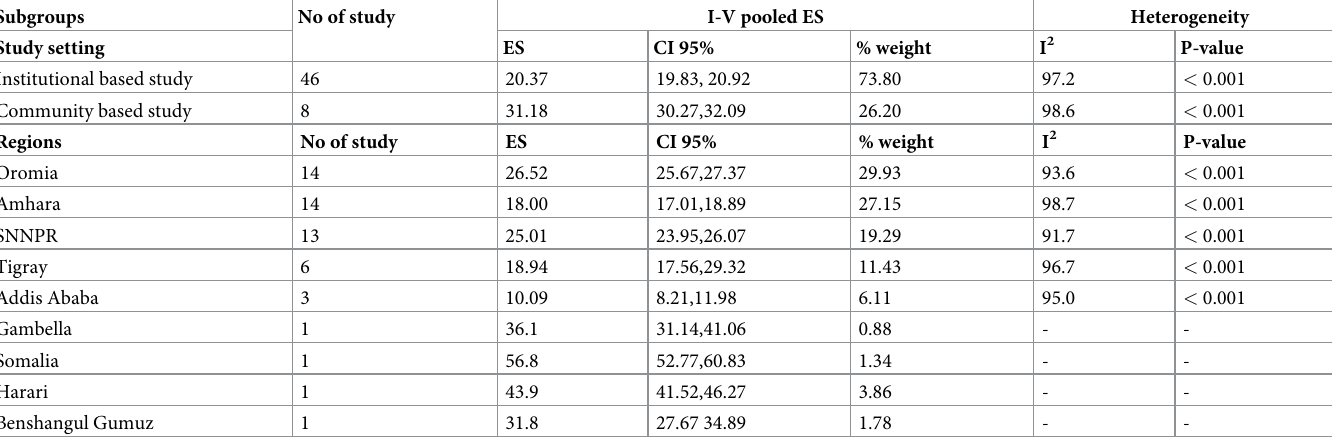
Table 2. Subgroup analysis on the prevalence of anemia among pregnant women in Ethiopia.